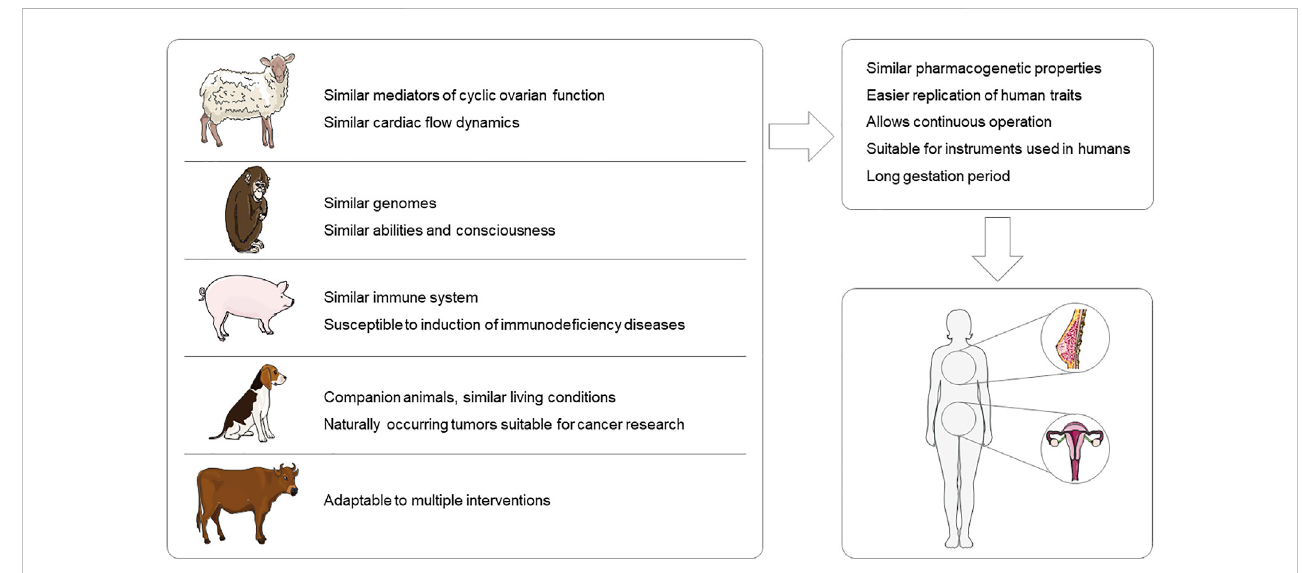
FIGURE 1 Advantages of large animal models for gynecological disease research. This fi gure was created using images from Servier Medical Art Commons Attribution 3.0 Unported License